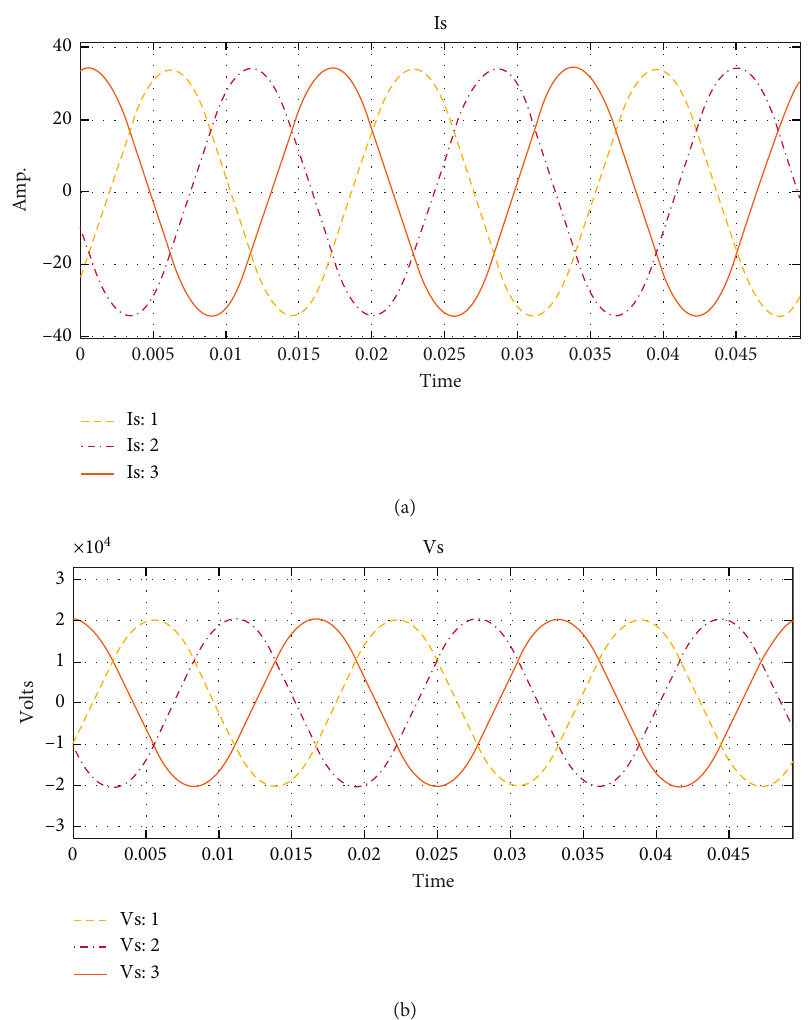
Figure 5: PMU current and voltage signals with